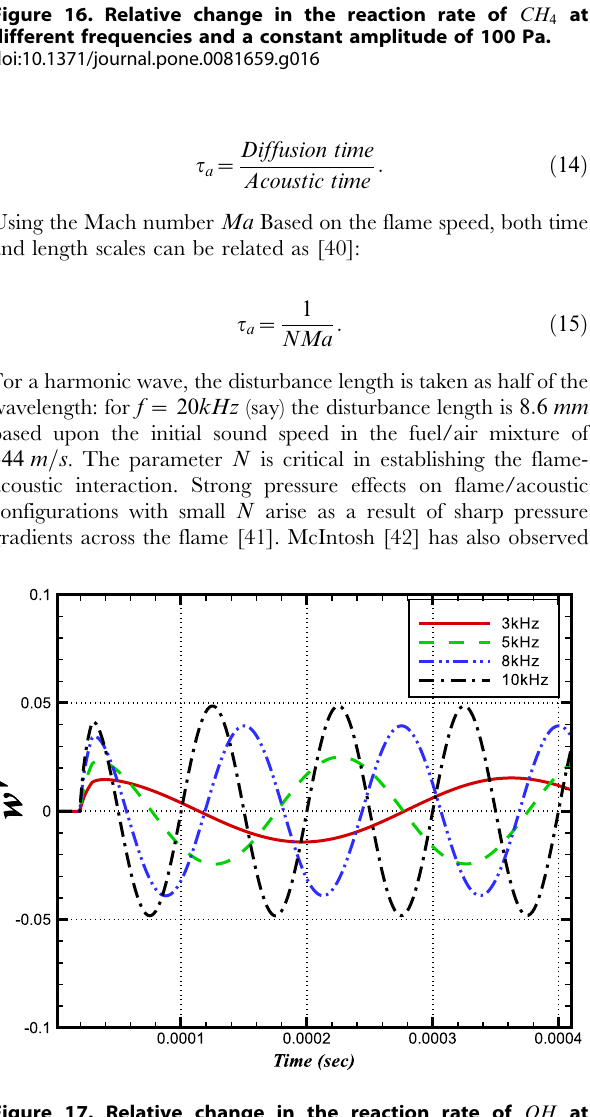
Figure 15. Relative change in the heat release at different frequencies and a constant amplitude of 100 Pa.